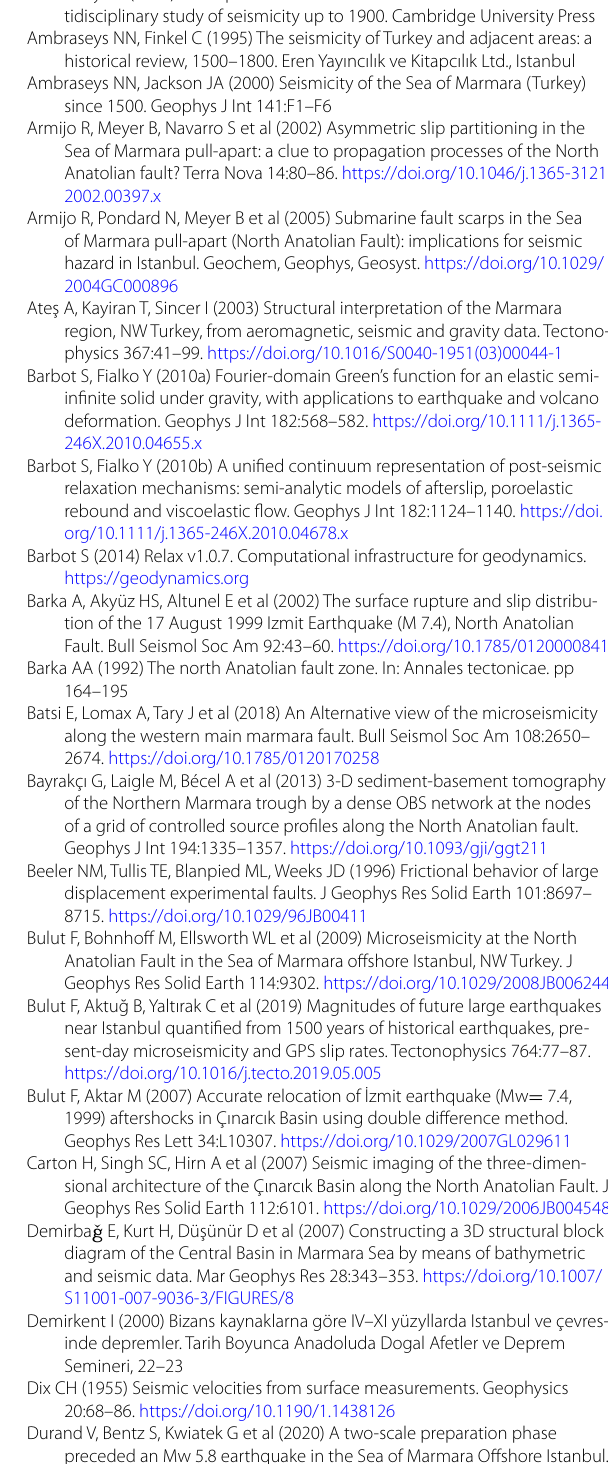
Figure_S10.html). Table S1. Source mechanism solution of the Silivri earthquakes larger than M